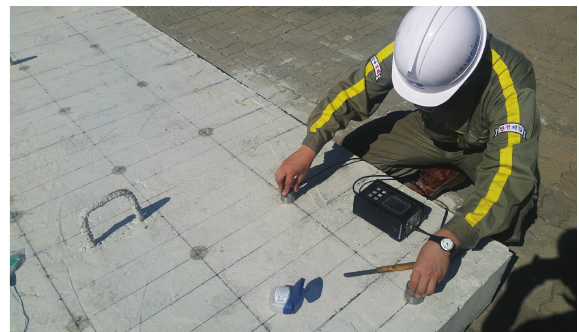
Figure 8: P-wave measurement in a grid on the concrete slab surface.